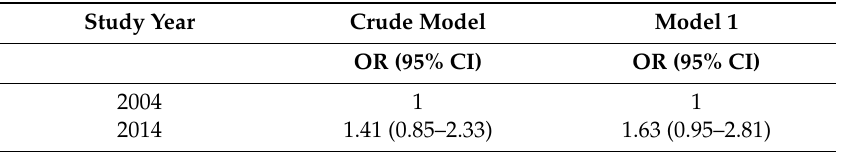
Table 5. Odds ratio of diabetes mellitus in study year 2014 compared with study year 2004, among Yangon citizens, Yangon, Myanmar, from logistic regression